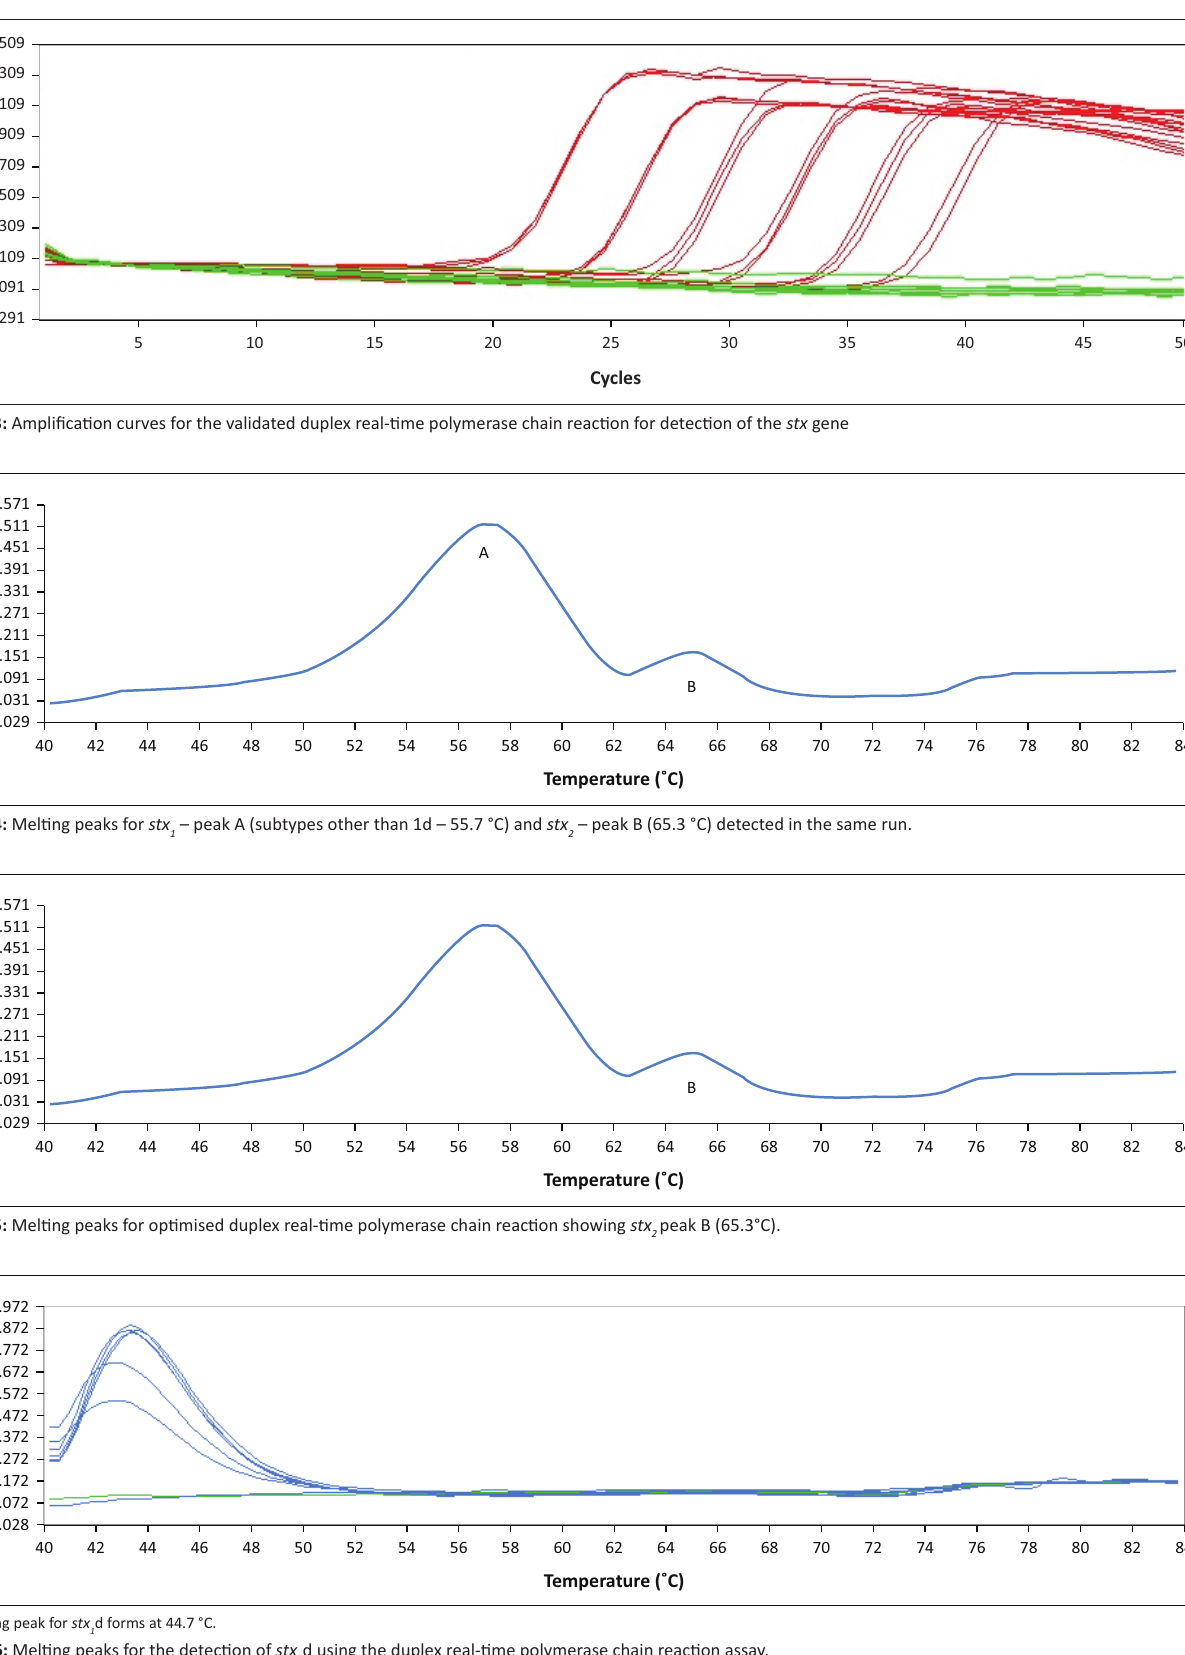
d using the duplex real-time polymerase chain reaction 1